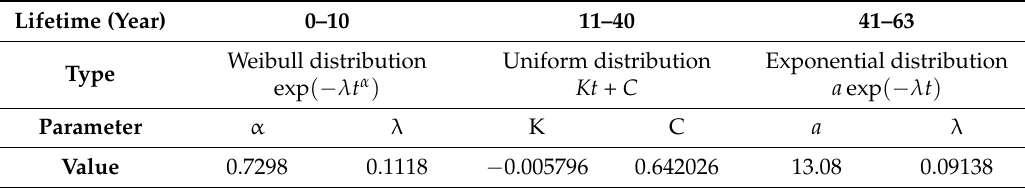
Table 1. Survival function parameter of different stages.